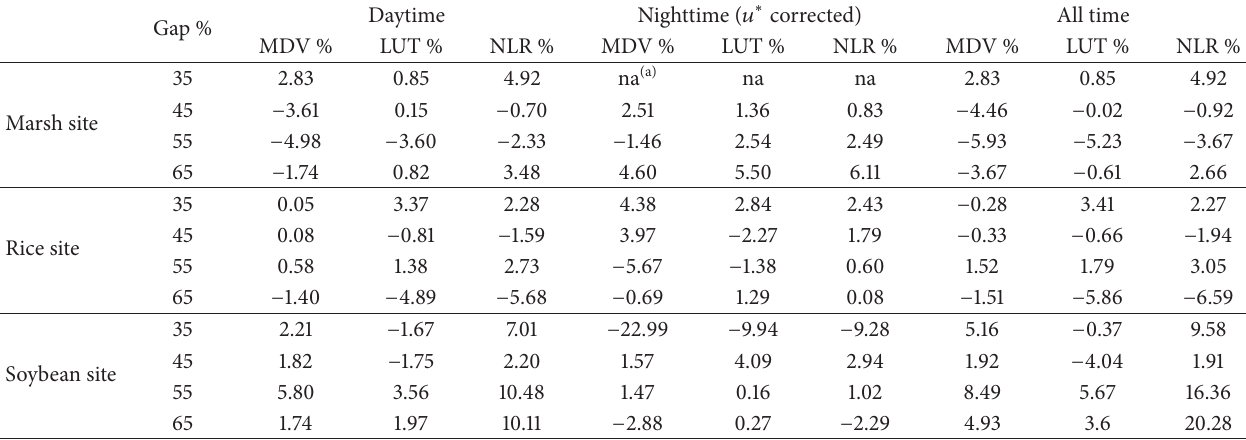
Table 5: The sum relative error (SRE) for NEE in different gap levels, at marsh, rice, and soybean site. Gap